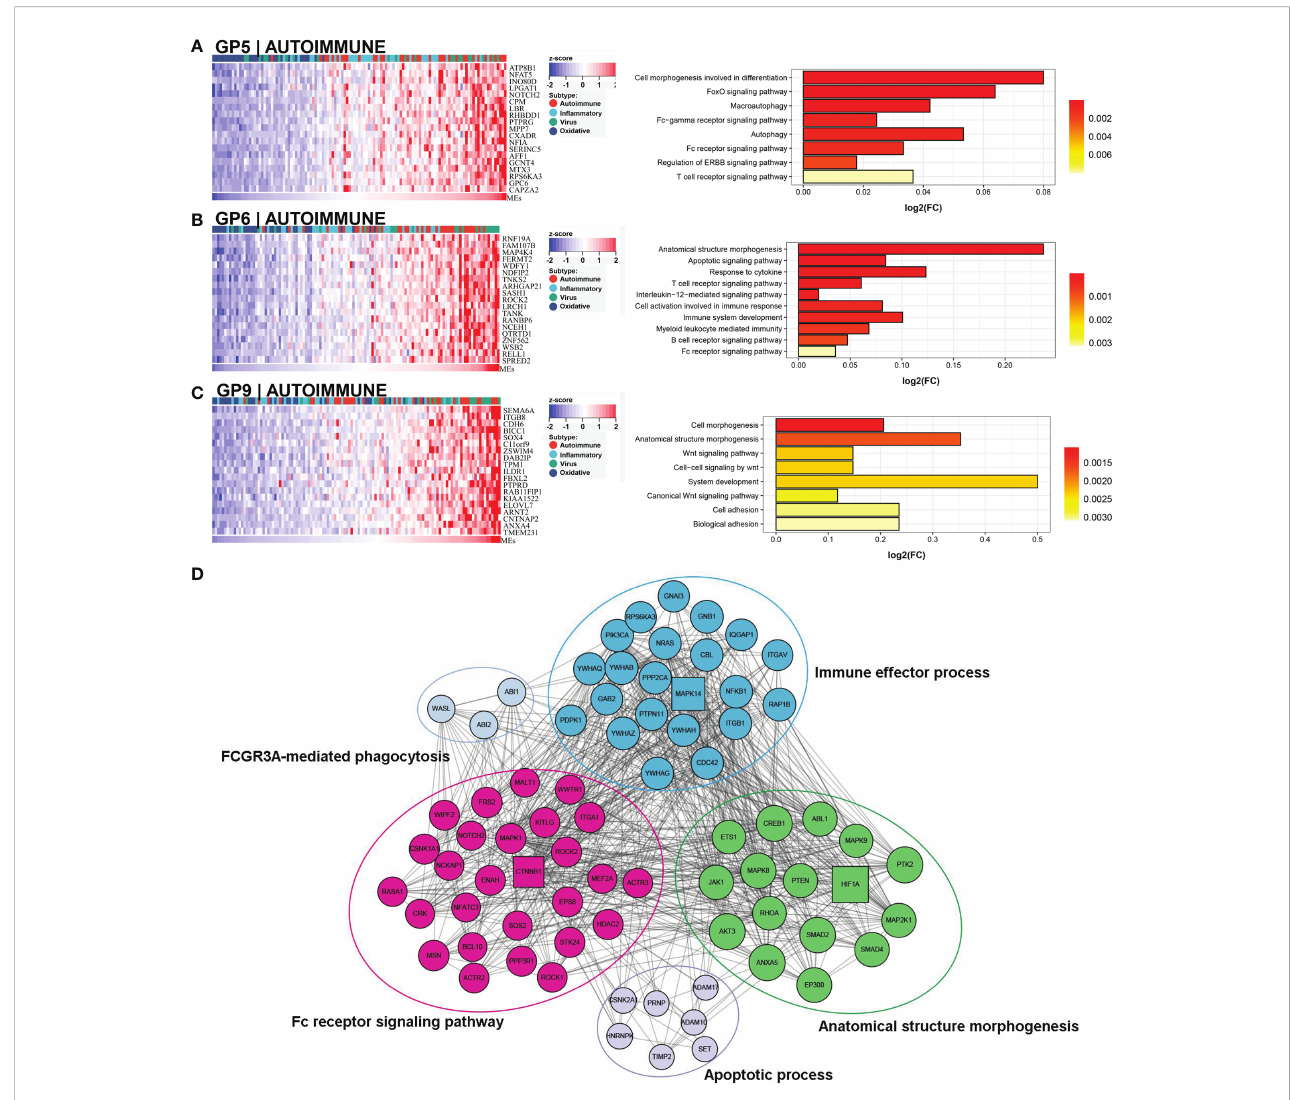
FIGURE 4 Core GP de fi ning the autoimmune subtype. GP5 revealed autoimmune-related biological processes (A) . GP6 revealed immune-related processes (B) . GP9 showed biological processes of anatomical morphogenesis (C) . The protein-protein interaction network revealed the protein interactions and enriched pathways of representative genes in the autoimmune subtype (D)